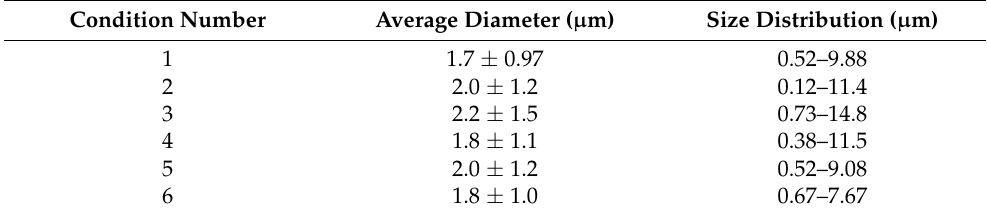
Table 2. Effect of the set experimental conditions on the average diameter and size distribution range of the CMC.BTA-MS obtained by spray